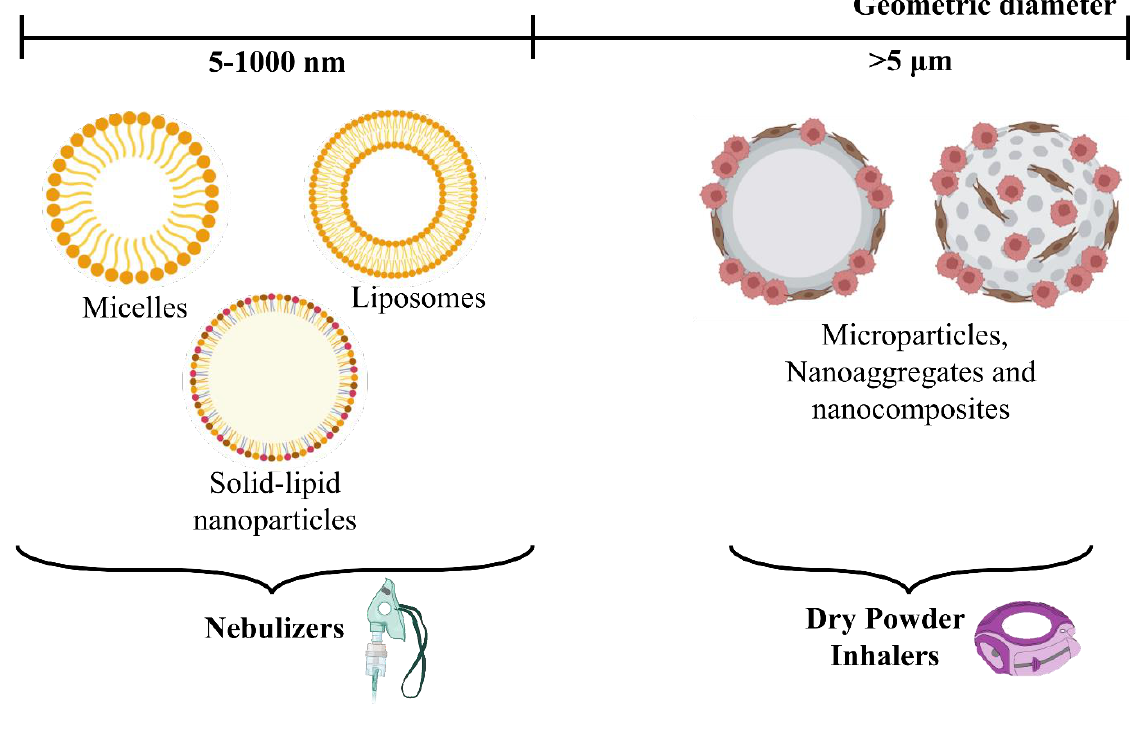
Figure 9. Drug delivery device choice based on the size of the formulation.